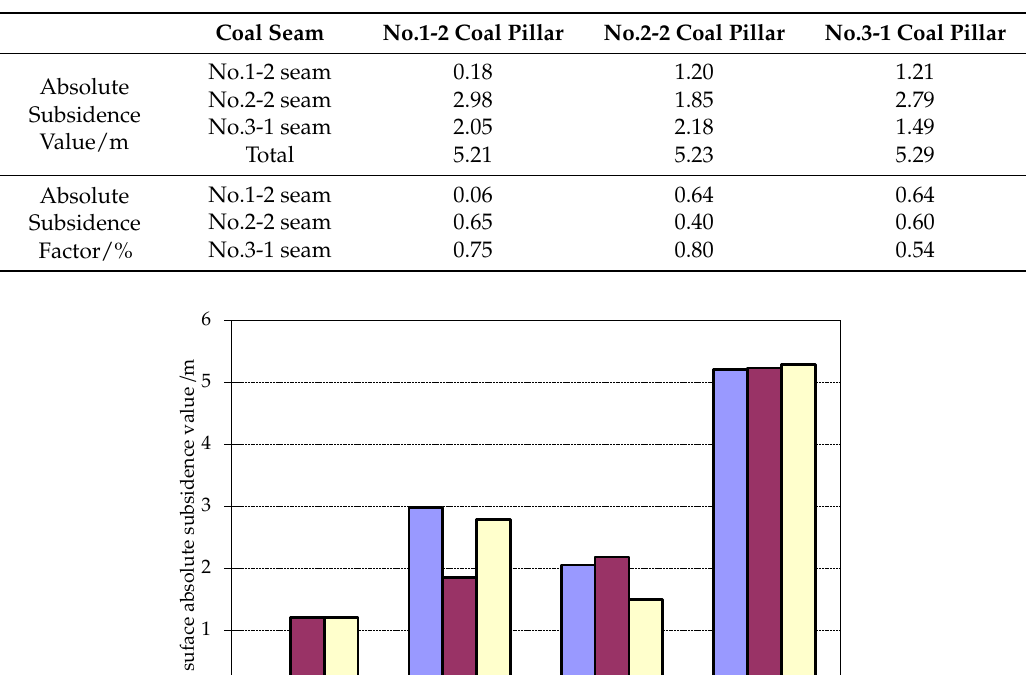
Figure 20. Surface subsidence uniformly with reasonable coal pillars. Table 2. Absolute subsidence value and factor in coal pillars position after multiple-seam mining.